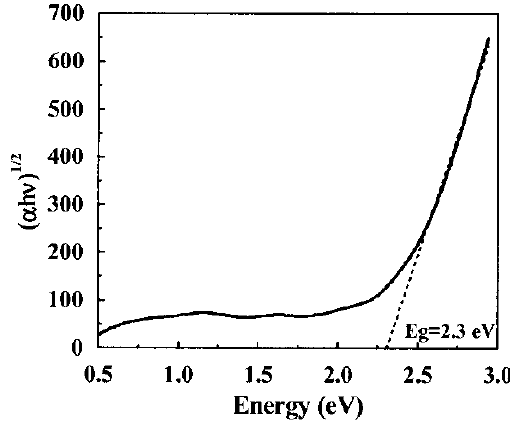
FIGURE 7 Fit of the absorption coefficient by Tauc’s